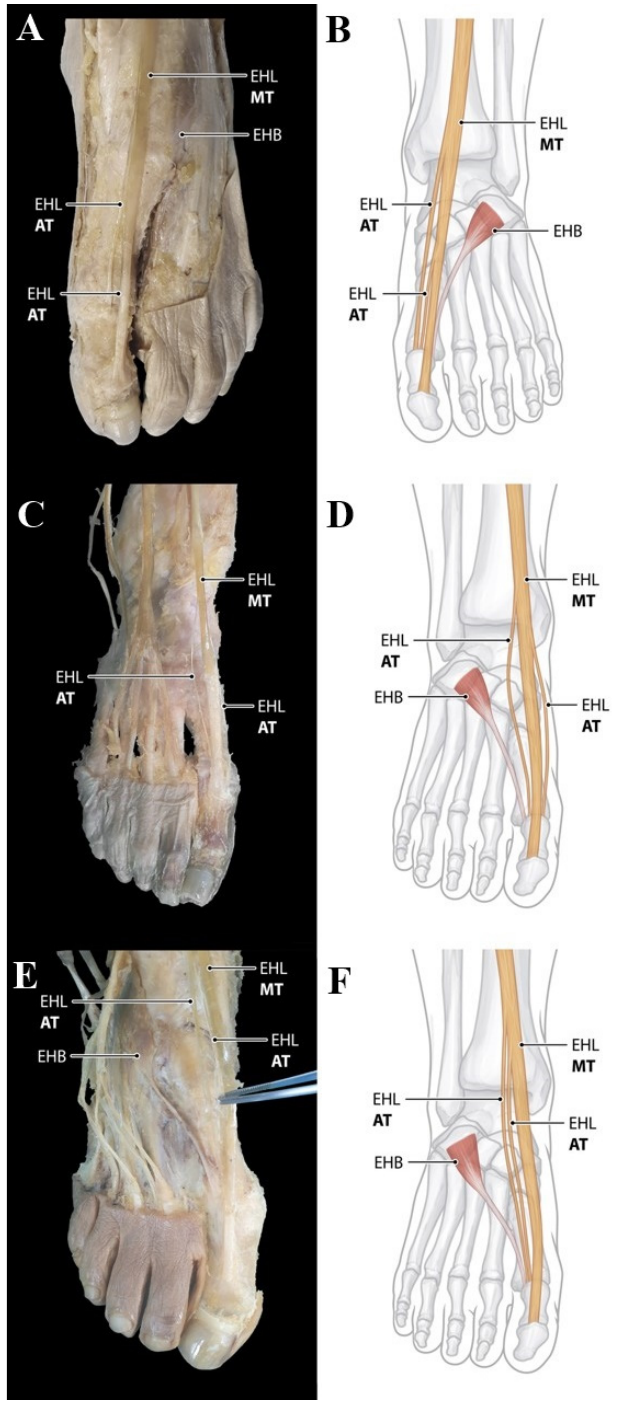
Figure 4. Type 3 EHL tendon variation. ( A ) Photo of Subtype 3B. Two accessory tendons arise from the medial side of the main tendon and insert into the capsule of first metatarsophalangeal joint. ( B ) Schematic drawing of Subtype 3B. ( C ) Photo of Subtype 3C. Two accessory tendons arise from the medial and lateral side of the main tendon and insert into the capsule of first metatarsophalangeal joint. ( D ) Schematic drawing of Subtype 3C. ( E ) Photo of Subtype 3K. Two accessory tendons arise from the lateral side of the main tendon and insert into the capsule of first metatarsophalangeal joint. ( F ) Schematic drawing of Subtype 3K. AT, accessory tendon; EHB, extensor hallucis brevis tendon; EHL, extensor hallucis longus tendon; MT, main tendon.